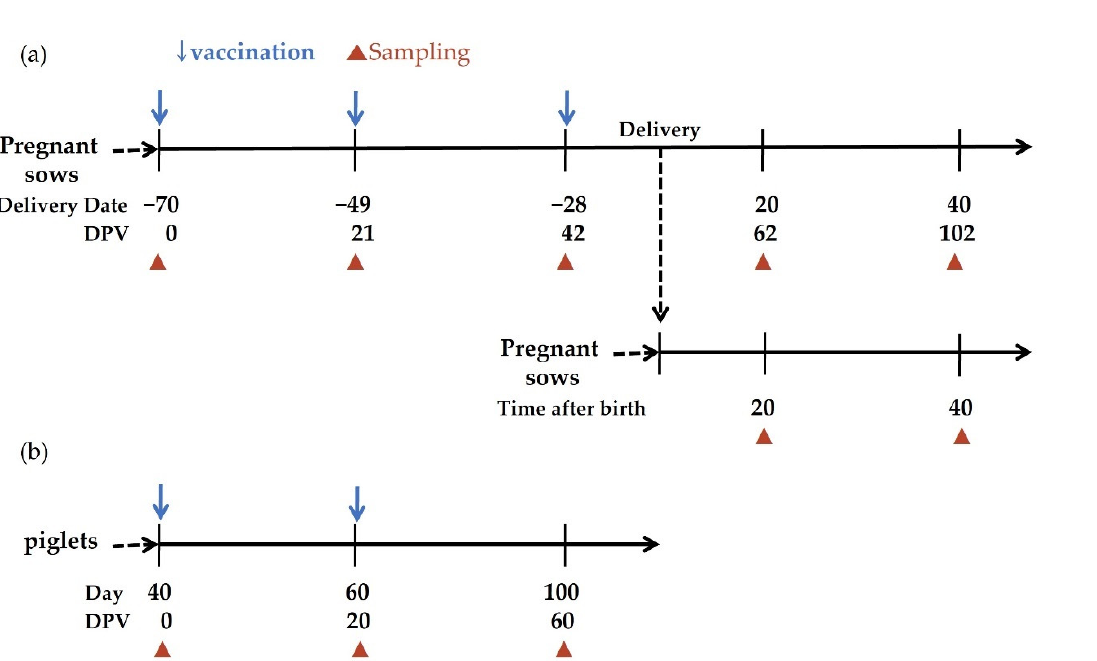
in a growth facility for 4 weeks. Aerial parts of plants were harvested and used for puri-